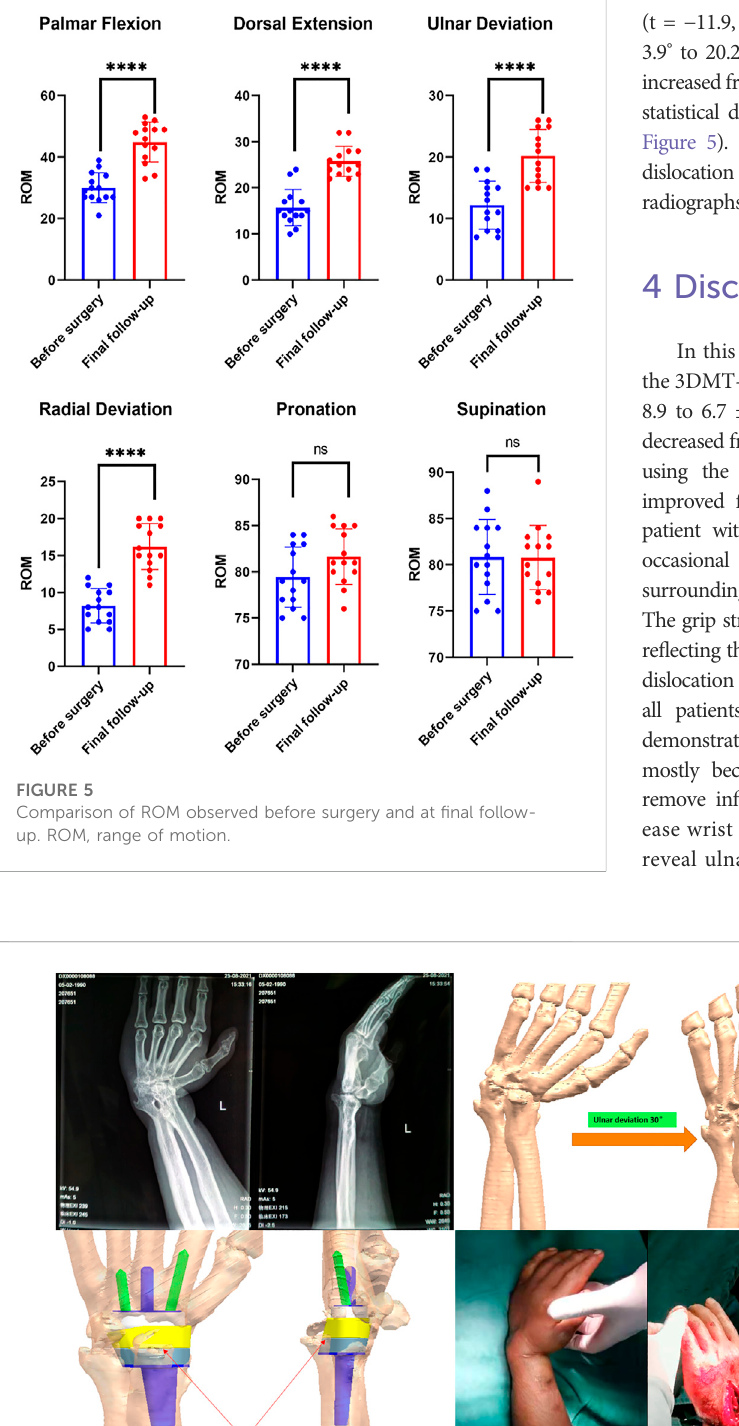
Frontiers in Bioengineering and